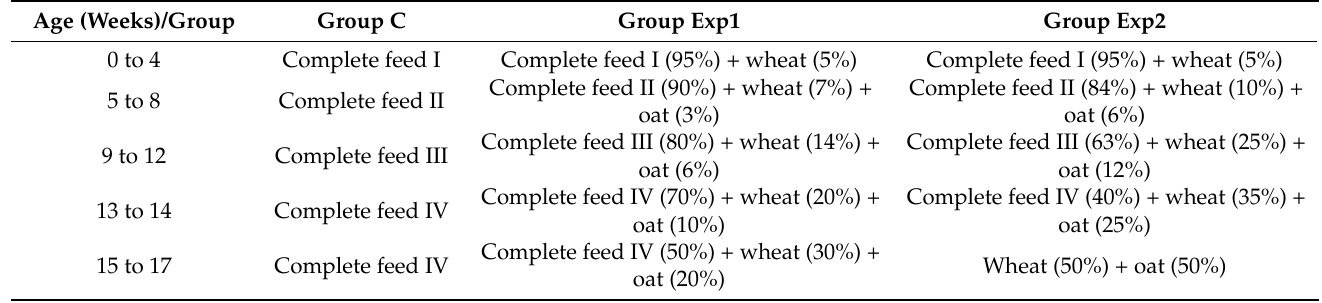
Table 1. Feeding schedule of control (C) and experimental (Exp) groups of organic turkeys.